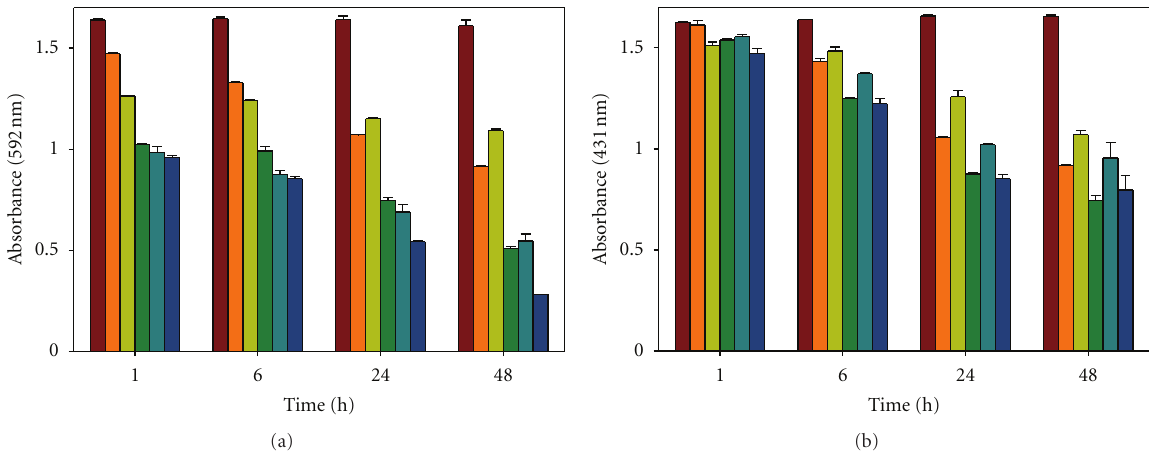
Figure 4: Decolorization of CV (a) and PR (b) by extracellular liquid from cultures of T. versicolor performed with several lignocellulosic residues: (maroon) control (noninoculated liquid medium), (orange) culture with no additive, (light green) corn cob, (dark green) wheat straw, (teal) grape seeds, and (navy blue) grape stalks. Decolorization of CV and PR was followed by decrease in absorbance at 592 and 431nm, respectively.